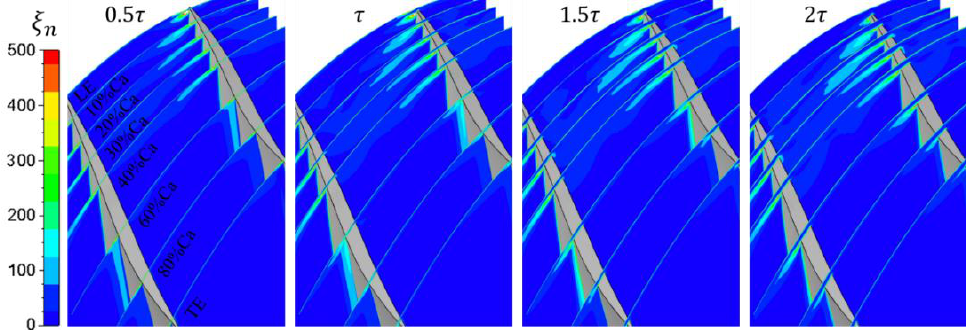
Figure 10. Absolute vorticity contours of rotor passage tip region at P1.